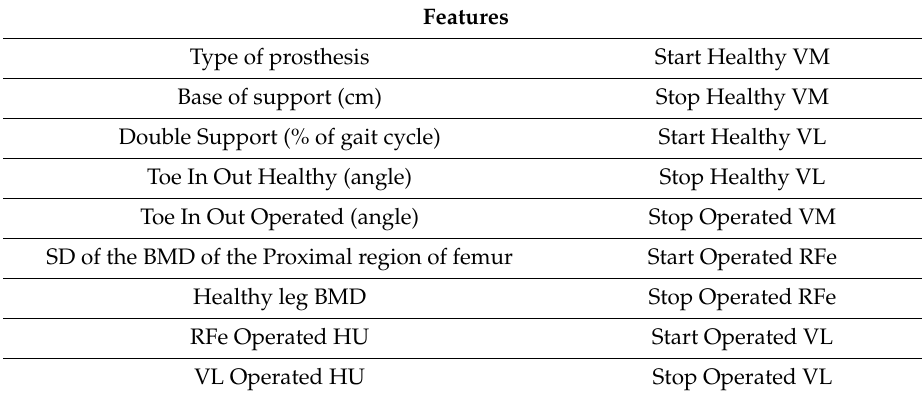
Table 4. Features chosen through the correlation